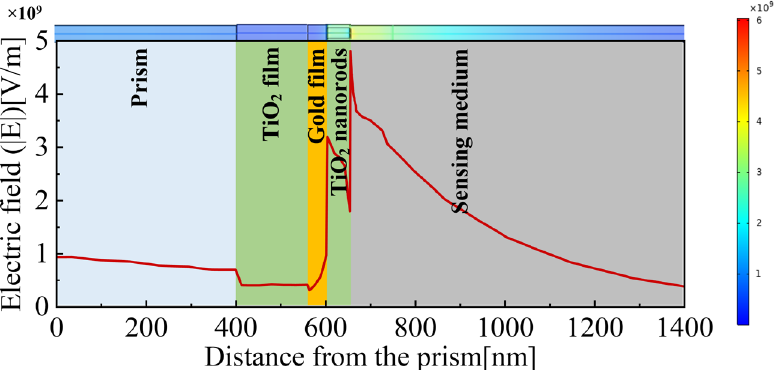
Figure 11. The electric field (|E|) distribution of the optimized TiO 2 (film)-Au-TiO 2 (nanorods) triple SPR sensor at resonance wavelength.